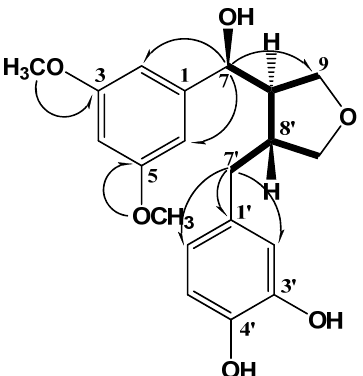
Figure 2. Key 1 H  1 H COSY (bold dash) and HMBC (arrow) correlations of compound 1